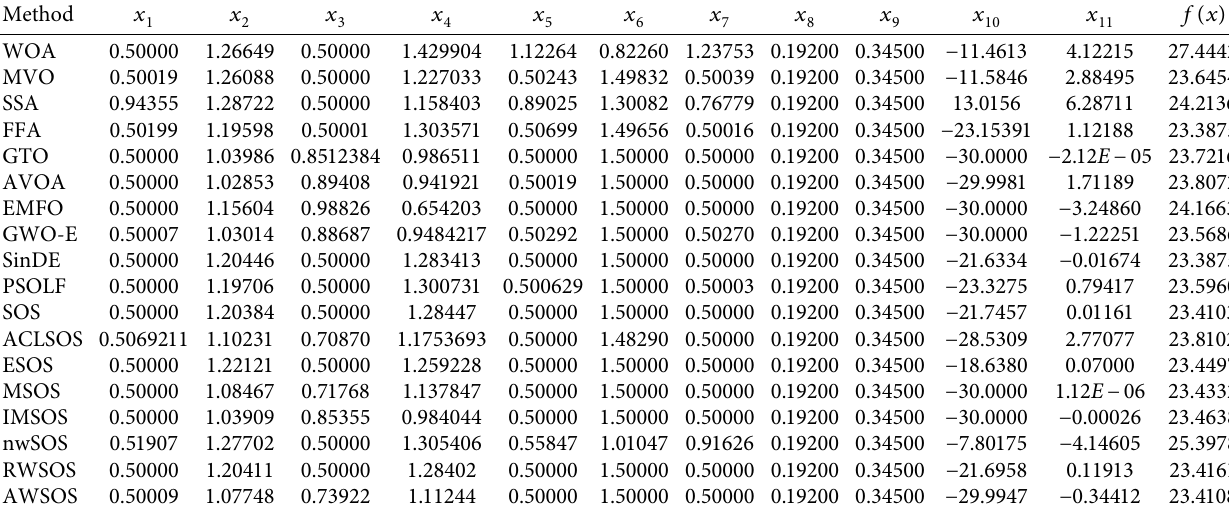
Table 25: Comparison of the results on the car side impact design